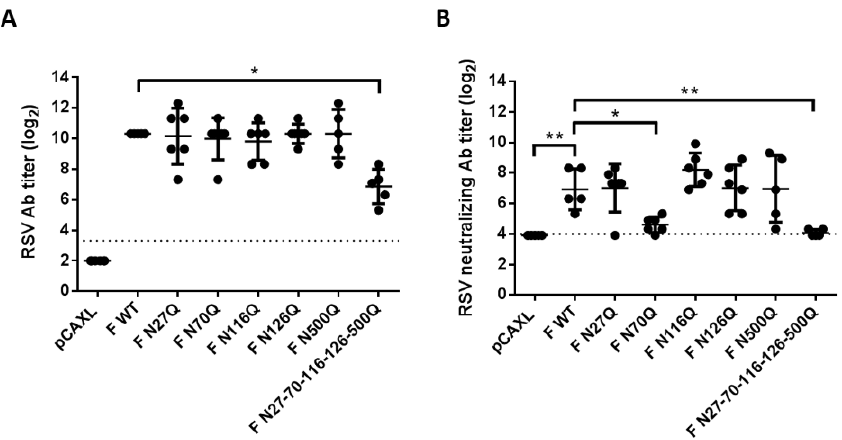
Figure 6. Antibody responses after DNA immunization of BALB/c mice. Two subsequent immunizations of the indicated plasmids were intramuscularly administered to BALB/c mice. Serum was collected 2 weeks after the second immunization. ( A ) HEp-2 monolayers were infected with RSV A2-K-line19F for 24 h and methanol fixed afterwards. Serum antibody titres were determined by titration of 2-fold serial dilutions of heat-inactivated serum. Binding of the antibodies was detected by HRP-conjugated goat anti-mouse IgG. Endpoint titres were determined by light microscopic analysis. ( B ) PRNT were performed to determine neutralizing antibody responses after boost immunization. Serial two-fold dilutions of heat-inactivated serum were incubated with RSV A2-K-line19F for 1 h at 37 ◦ C prior to inoculation of HEp-2 monolayers. Plaques were visualized by immunostaining with palivizumab and HRP-conjugated secondary antibodies. The 50% endpoint titres were determined by manual plaque counting. The dotted line represents the detection limit. * p < 0.05; ** p < 0.01; n = 5–6 animals/group (Student’s unpaired two-tailed t test).